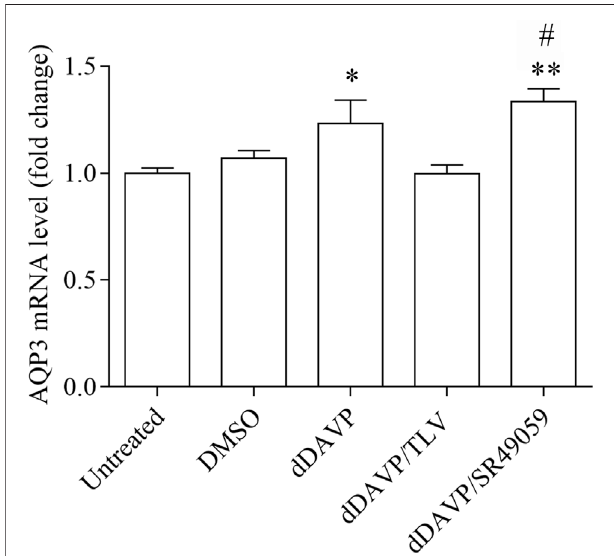
FIGURE 4 | AQP3 gene expression in HCT8 cells. Real-Time PCR was performed as described in the Methods. Treatment with dDAVP signi fi cantly increasedAQP3mRNAlevelcomparedwithuntreatedcells.Cotreatmentwith dDAVP and SR49059 signi fi cantly increased AQP3 mRNA compared to untreated cells. By contrast, cotreatment with dDAVP and tolvaptan did not alter the AQP3 mRNA level. Data are shown as mean ± S.E.M. of 6 independent experiments and analyzed by one-way ANOVA followed by Dunnett ’ s Multiple Comparison test (* p < 0.05 and ** p < 0.01 vs. untreated; # p < 0.05 vs. DMSO).